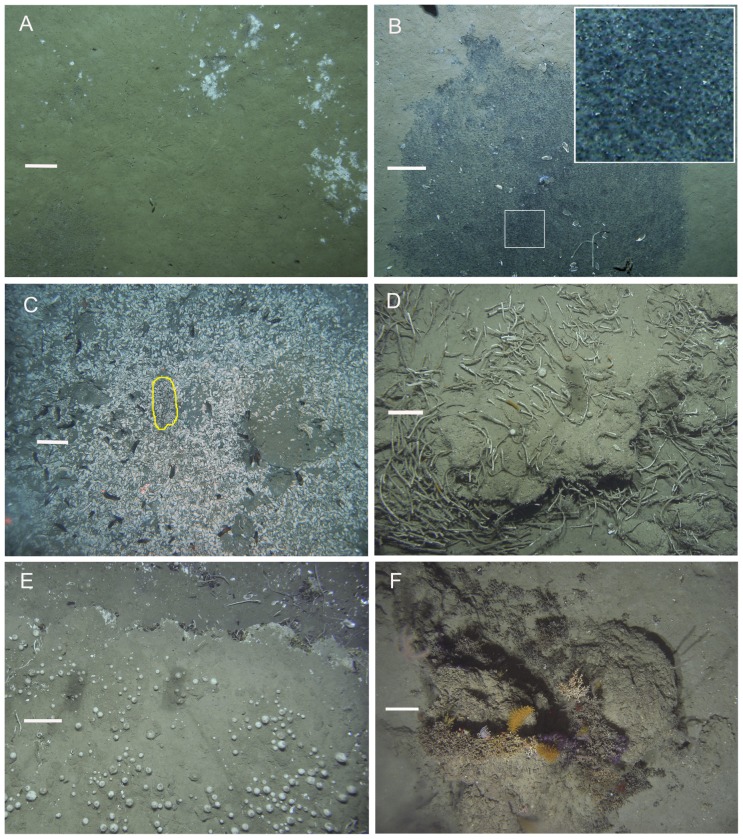
Hikurangi Margin cold seep habitats and fauna (1).(A) bacterial mats on soft sediments at North Tower; (B) sulphide-rich sediment patch with high density ampharetid polychaete population and (inset) characteristic ‘raindrop’ patterning at North Tower; (C) extensive Calyptogena sp. shell valves surrounding a population of live clams (yellow outline) with live and dead Bathymodiolus sp. mussels at Tui; (D) high density Lamellibrachia sp. tubeworm population at Southwest Moa showing tubes emerging from upper surface of carbonate concretions; (E) high densities of Stelletta n. sp. sponges and Bathymodiolus sp. mussels (along ledge at top) at Southwest Moa, and (F) scleractinian and gorgonian corals on weathered carbonates at Moa. Scale bars show 0.2 m.